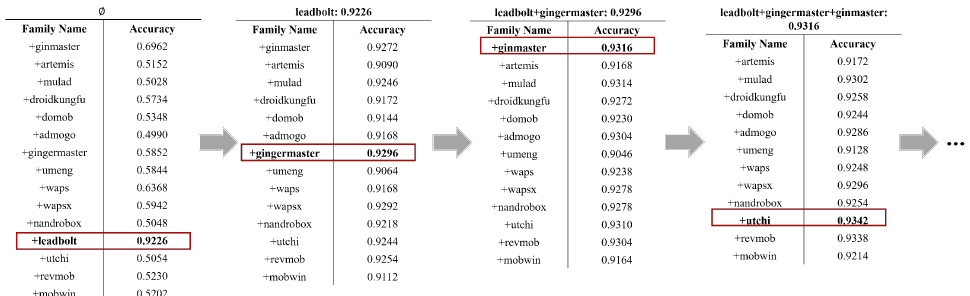
Figure 1. Study of SFS for plankton using Drebin.The number in bolds and the red box show the best